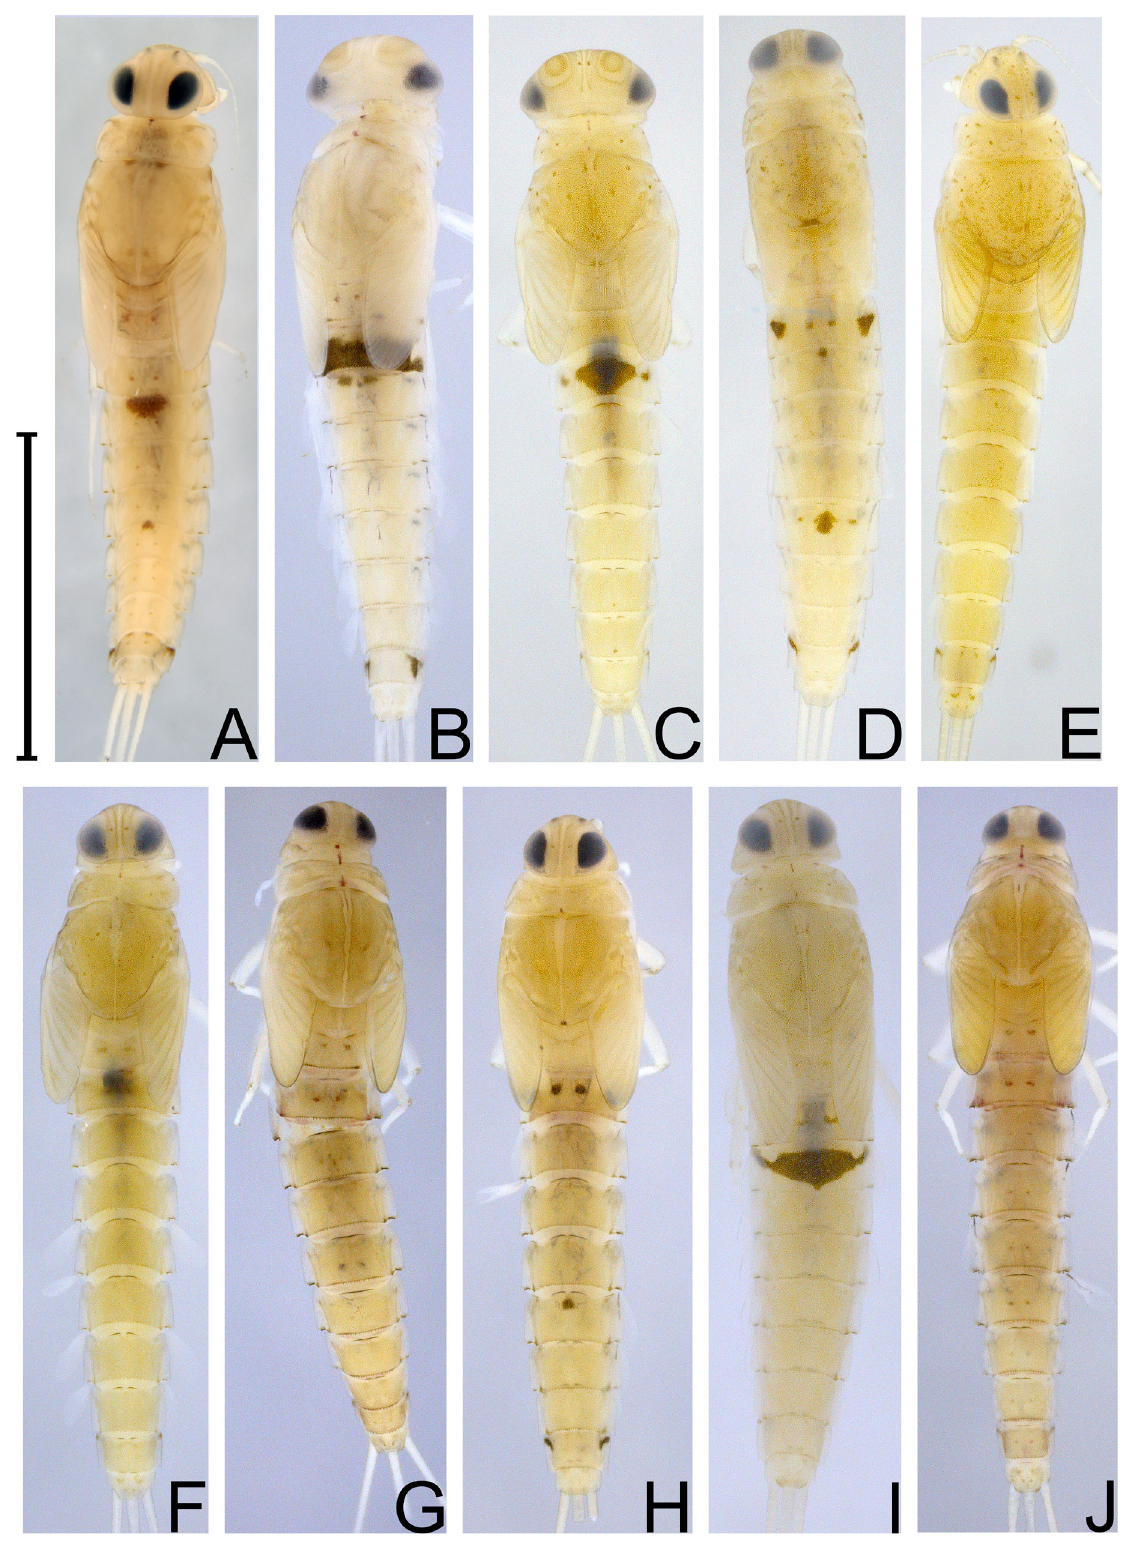
Fig. 7. Rivudiva amazona sp. nov., dorsal habitus of nymphs, variation of pigmentation pattern. A . Holotype (INPA). B–J . Paratypes (INPA). Scale bar = 1.65